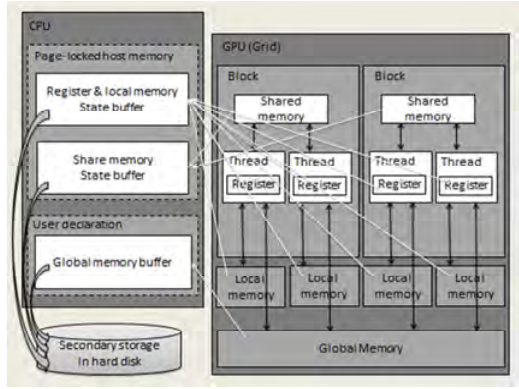
Fig. 1. Collecting and Saving Computation State of GPU